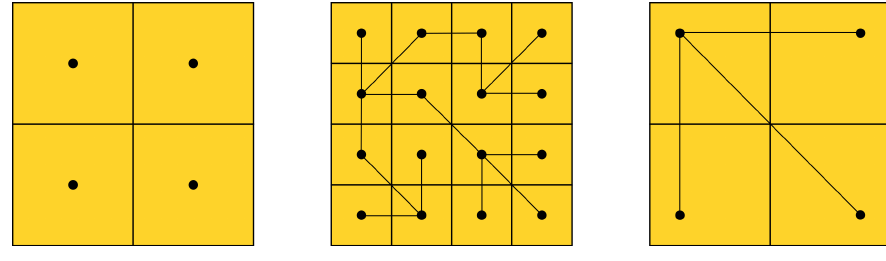
Figure 4: Schematic for points in the sets Y 1 (left), Y 2 = V 2 (center), and V 1 (right) for a self-similar IFS for the square and generation N = 2 . Possible realizations of the trees T 1 (right) and T 2